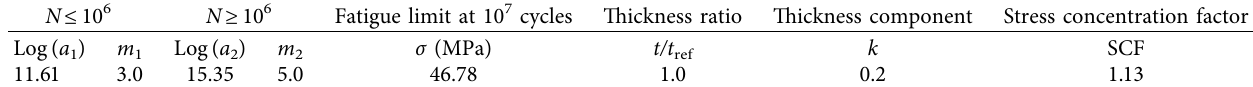
Figure 10: The time history of the stochastic ice force for the present bridge ( T � 500s). Table 1: S-N curves parameters, according to [18].